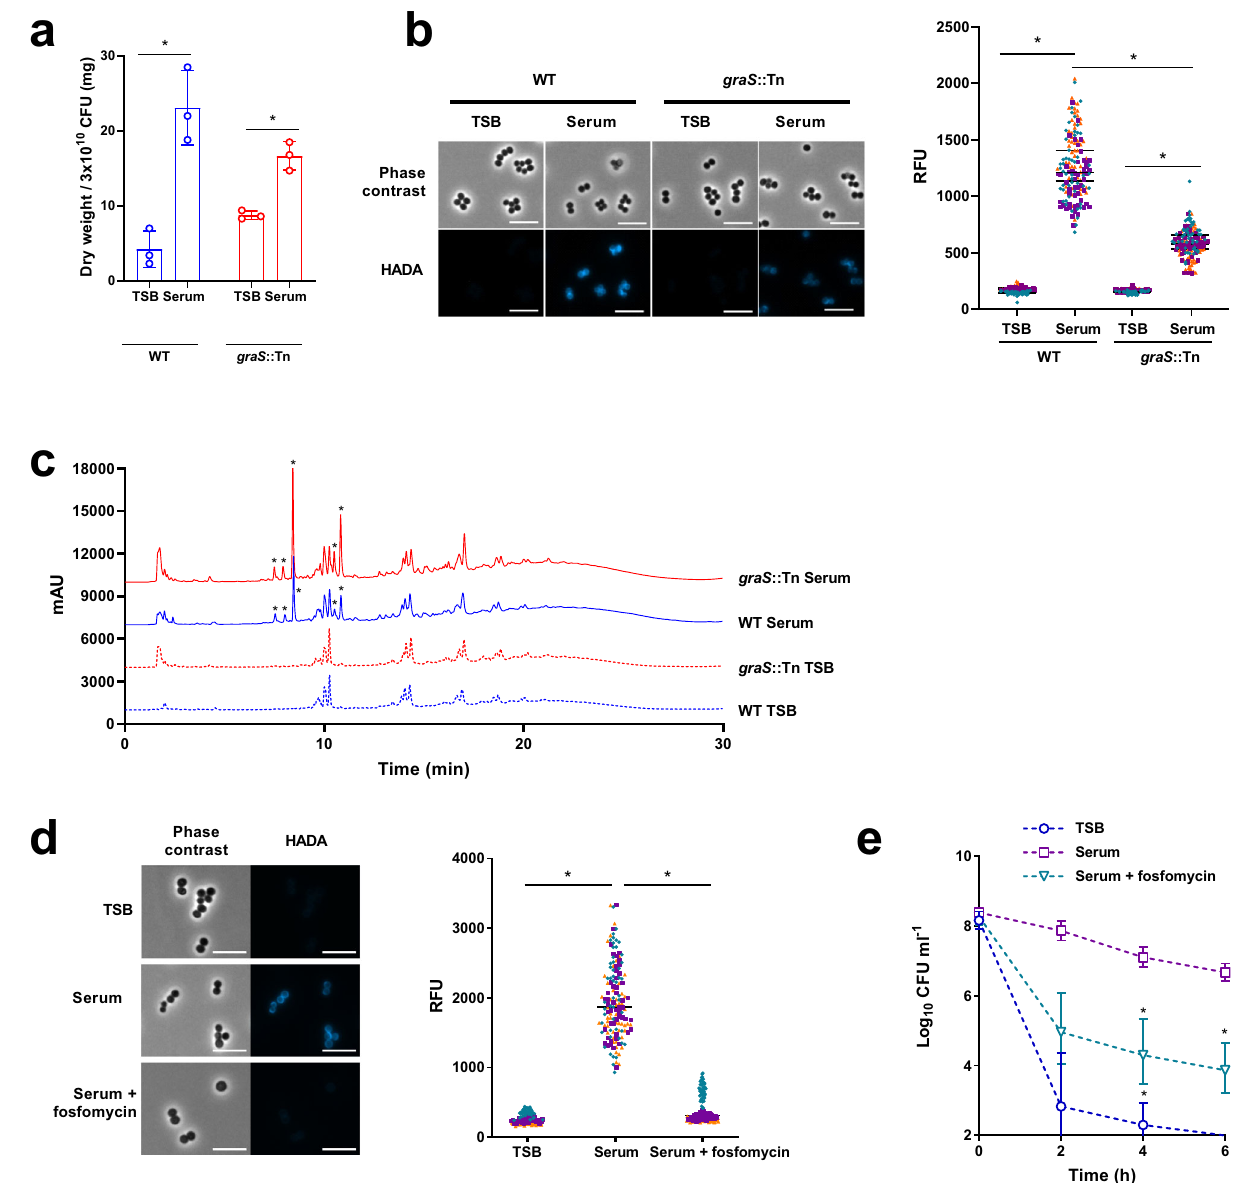
Fig. 5 GraRS-mediated increase in peptidoglycan partially explains serum-induced tolerance. Dry weight of peptidoglycan extracted from 300 ml cultures of TSB-grown or serum-adapted S. aureus JE2 WT or the graS ::Tn mutant strain ( a ). Phase contrast and fl uorescence microscopy of TSB-grown and serum-adapted cultures of S. aureus WT and the graS ::Tn mutant strain ( b ). Scale bars, 5 μ m. The fl uorescence of individual cells was quanti fi ed. Graph represents the fl uorescence of 50 cells per biological replicate (150 cells in total) with the mean of each replicate indicated. Each biological replicate is depicted in a different colour. Peptidoglycan from panel ( a ) was analysed by rp-HPLC ( c ). Asterisks denote peaks present in serum-adapted but not TSB- grown samples. Phase contrast and fl uorescence microscopy of TSB-grown, serum-adapted or serum + 64 μ g ml − 1 fosfomycin-adapted cultures of S. aureus JE2 WT ( d ). Scale bars, 5 μ m. The fl uorescence of individual cells was quanti fi ed and different colours represent different biological replicates. Log 10 CFU ml − 1 of bacteria depicted in panel ( d ) during a 6 h exposure to 80 μ g ml − 1 daptomycin in serum ( e ). Graph in ( a ) represents the mean ± standard deviation of three independent experiments and data were analysed by two-way ANOVA with Sidak ’ s post-hoc test (* P < 0.0001 (WT), = 0.0217 ( graS ::Tn)). Data in ( b ) and ( d ) were analysed by Kruskal – -Wallis with Dunn ’ s post hoc test (* for ( b ), P < 0.0001 (WT), <0.0001 ( graS ::Tn). For ( d ), P < 0.0001 (TSB vs Serum), P < 0.0001 (Serum vs Serum + fosfomycin)). Data in ( e ) represent the geometric mean ± geometric standard deviation of three independent experiments and were analysed by two-way ANOVA with Dunnett ’ s post-hoc test (*, P = 0.0062 (4 h serum), 0.0379 (4 h serum + Fosfomycin), 0.0358 (6 h serum + fosfomycin); serum-adapted vs serum/fosfomycin-adapted at each time-point). The fi nal time point for TSB- grown cells fell below the limit of detection of 100 CFUml − 1 . CFU, colony-forming units; TSB, tryptic soy broth. Source data are provided as a Source Data fi